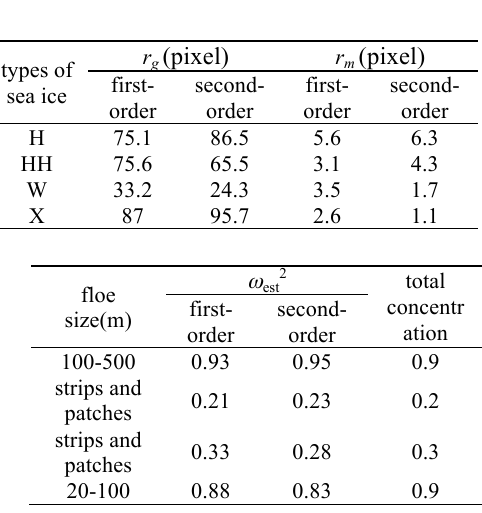
Table 3. Parameter estimation results of polygons in Fig. 9